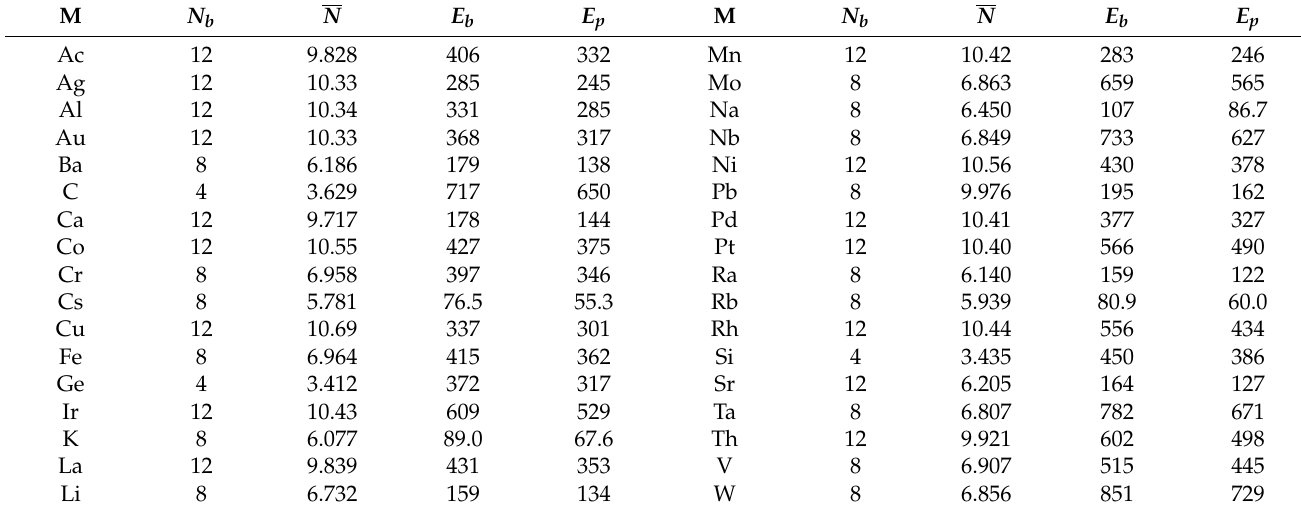
Table 5. Bulk and average coordination numbers of particles, cohesive energies (kJ/mol) in bulk